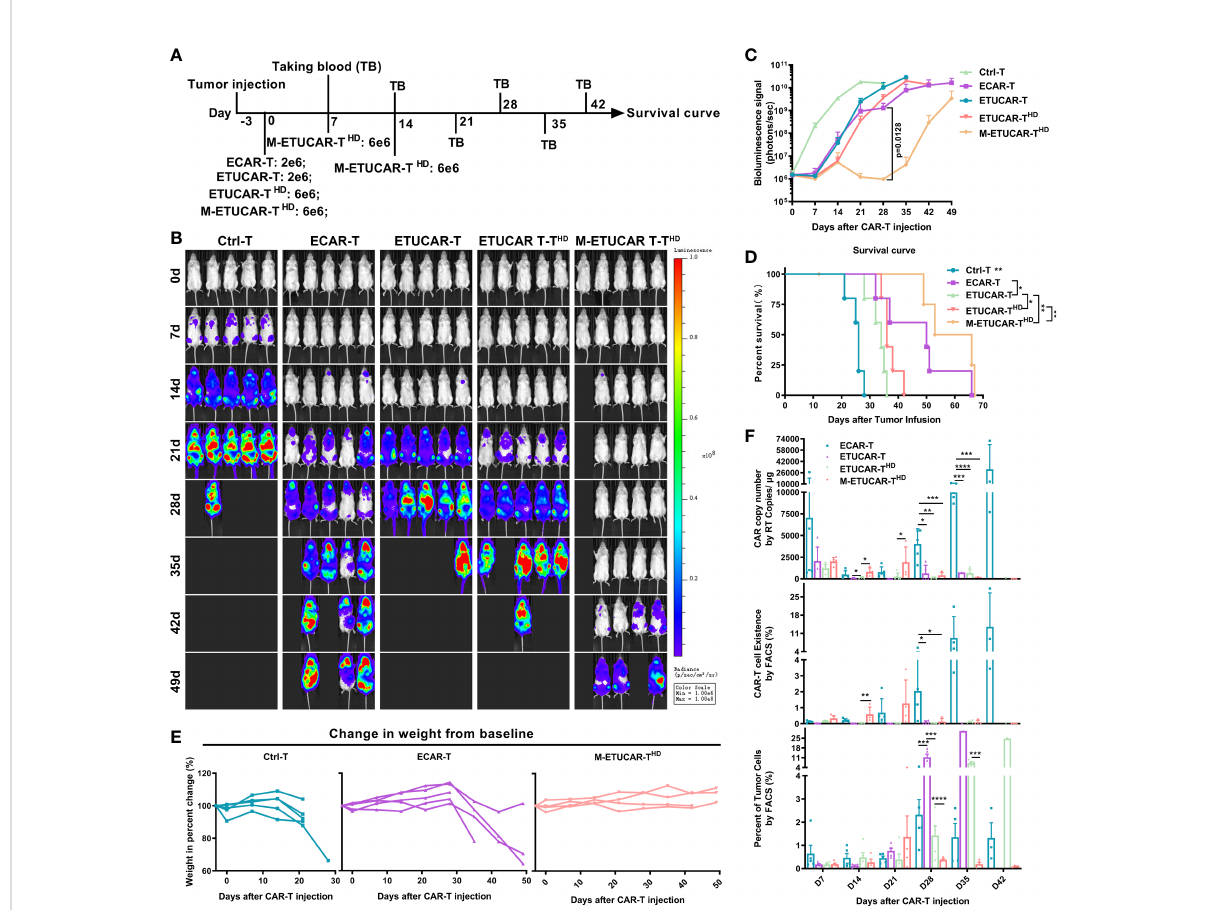
FIGURE 4 Improve ef fi cacy by increasing the dosage and frequency of CAR-T infusion. (A) , Animal experimental timeline. All cells were cryopreserved (off the self). Here, the dose of cryopreserved cells was double the conventional dose (2 × 10 6 ). (B, C) BLI from each group of mice (n = 5); the high-dose ETUCAR-T HD was three times conventional dosing (2 × 10 6 ) reinfusion, the three times conventional dosing for multiple reinfusion group (M-ETUCAR-T HD ). (D) , Survival curve of mice (n=5 per group). (E) Weight loss monitoring of mice receiving Ctrl-T (left), ECAR-T (center), or M-ETUCAR-T HD (right) cell treatment (n = 5). (F) , Peripheral blood from mice receiving different treatments were obtained every 7 days for the presence of the copies of the CAR transgene by RT-PCR (BBz) (top) and the Fluorescence-activated Cell Sorting (FACS) assay (CD45(+)/CD3 (+) CAR-T cells) (center) and the presence of tumor cells (bottom) (n = 5). All data represent the mean ± SD. Statistical signi fi cance was determined by one-way ANOVA with Tukey ’ s correction for multiple comparisons (C, F) , or the log-rank (Mantel – Cox) test (D) . Parts of the statistical signi fi cance in C were not